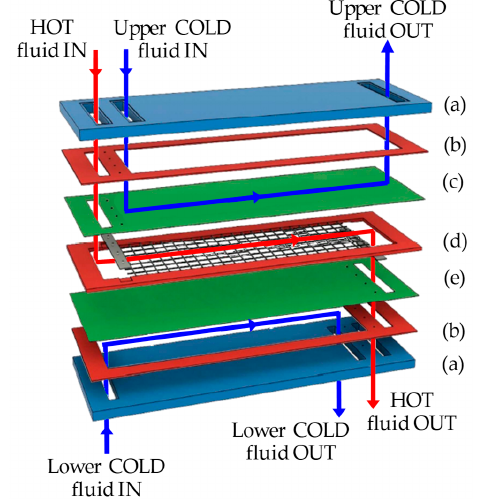
Figure 3. Exploded view of the test section, showing an overlapped spacer. ( a ) Transparent Plexiglas ® slab; ( b ) rubber gasket; ( c ) upper PC/TLC sandwich; ( d ) gasket and spacer; ( e ) lower PC/TLC sandwich.